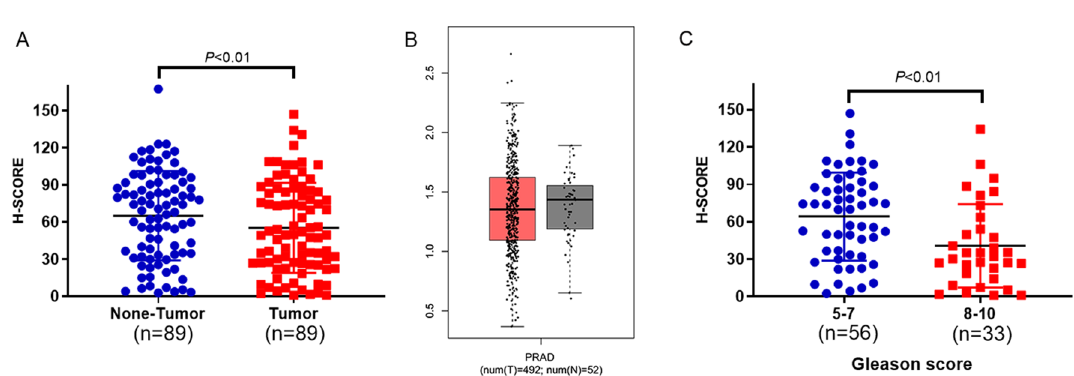
Figure 2. SIRT4 is downregulated in prostate cancer tissues and correlated with higher Gleason scores. ( A ) SIRT4 protein levels were measured in 89 prostate cancer tissues and paired with adjacent non-neoplastic prostate tissues using a tissue microarray. SIRT4 protein levels are lower in tumor tissues compared with adjacent non-neoplastic prostate tissues ( P < 0.01). Histochemical scores (H-SCORE) were analyzed by Quant center version 2.2 (3D HISTECH, Budapest, Hungary). Statistical analysis was performed using the statistical software program SPSS version 22.0 (IBM Corp., Armonk, NY, USA). ( B ) TCGA data were analyzed online using the GEPIA website (http:// gepia. cancer- pku. cn/ detail. php). Box plots depict the reduced expression of SIRT4 in prostate cancer (n = 492) than normal prostate tissue (n = 52) using bioinformatics analysis. ( C ) SIRT4 expression is lower in prostate patients with a higher Gleason score ( P < 0.01). The boxes represent the interquartile range, whiskers represent the 5th-95th percentile range, and bars represent the